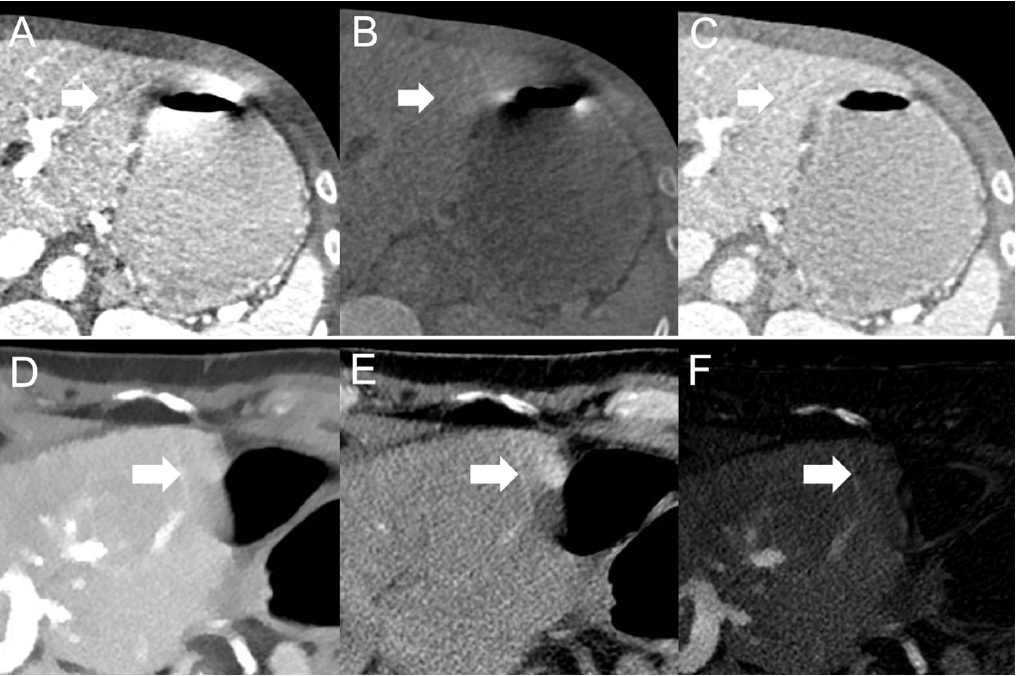
Figure 5. Visceral-motion-related artifact (arrows) appearance on images with ( A , D ) low X-ray photon energy and ( B , E ) high X-ray photon energy acquired with a dual-source (top row) and dual-layer spectral detector (bottom row) DECT scanner. As hyperdense artifact components on ( A ) low-energy dual-source images appear hypodense on ( B ) high-energy dual-source images, and vice versa, visceral-motion-related artifacts are substantially reduced on ( C ) blended 120-kVp-like dual-source images. As hyperdense artifact components on ( D ) low-energy dual-layer spectral detector images remain hyperdense on ( E ) high-energy dual-layer spectral detector images, and vice versa, visceral-motion-related artifacts are substantially reduced on ( F ) iodine dual-layer spectral detector